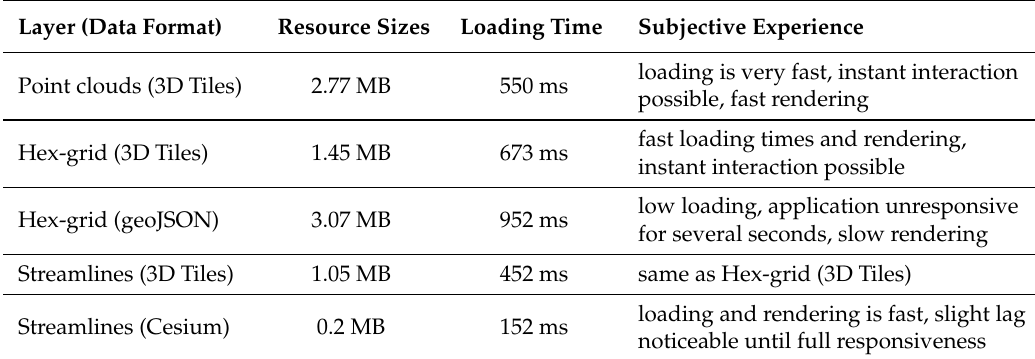
Table 4. Average loading times (out of 10 iterations), measured using Google Chrome Developer Tools. Table extended from